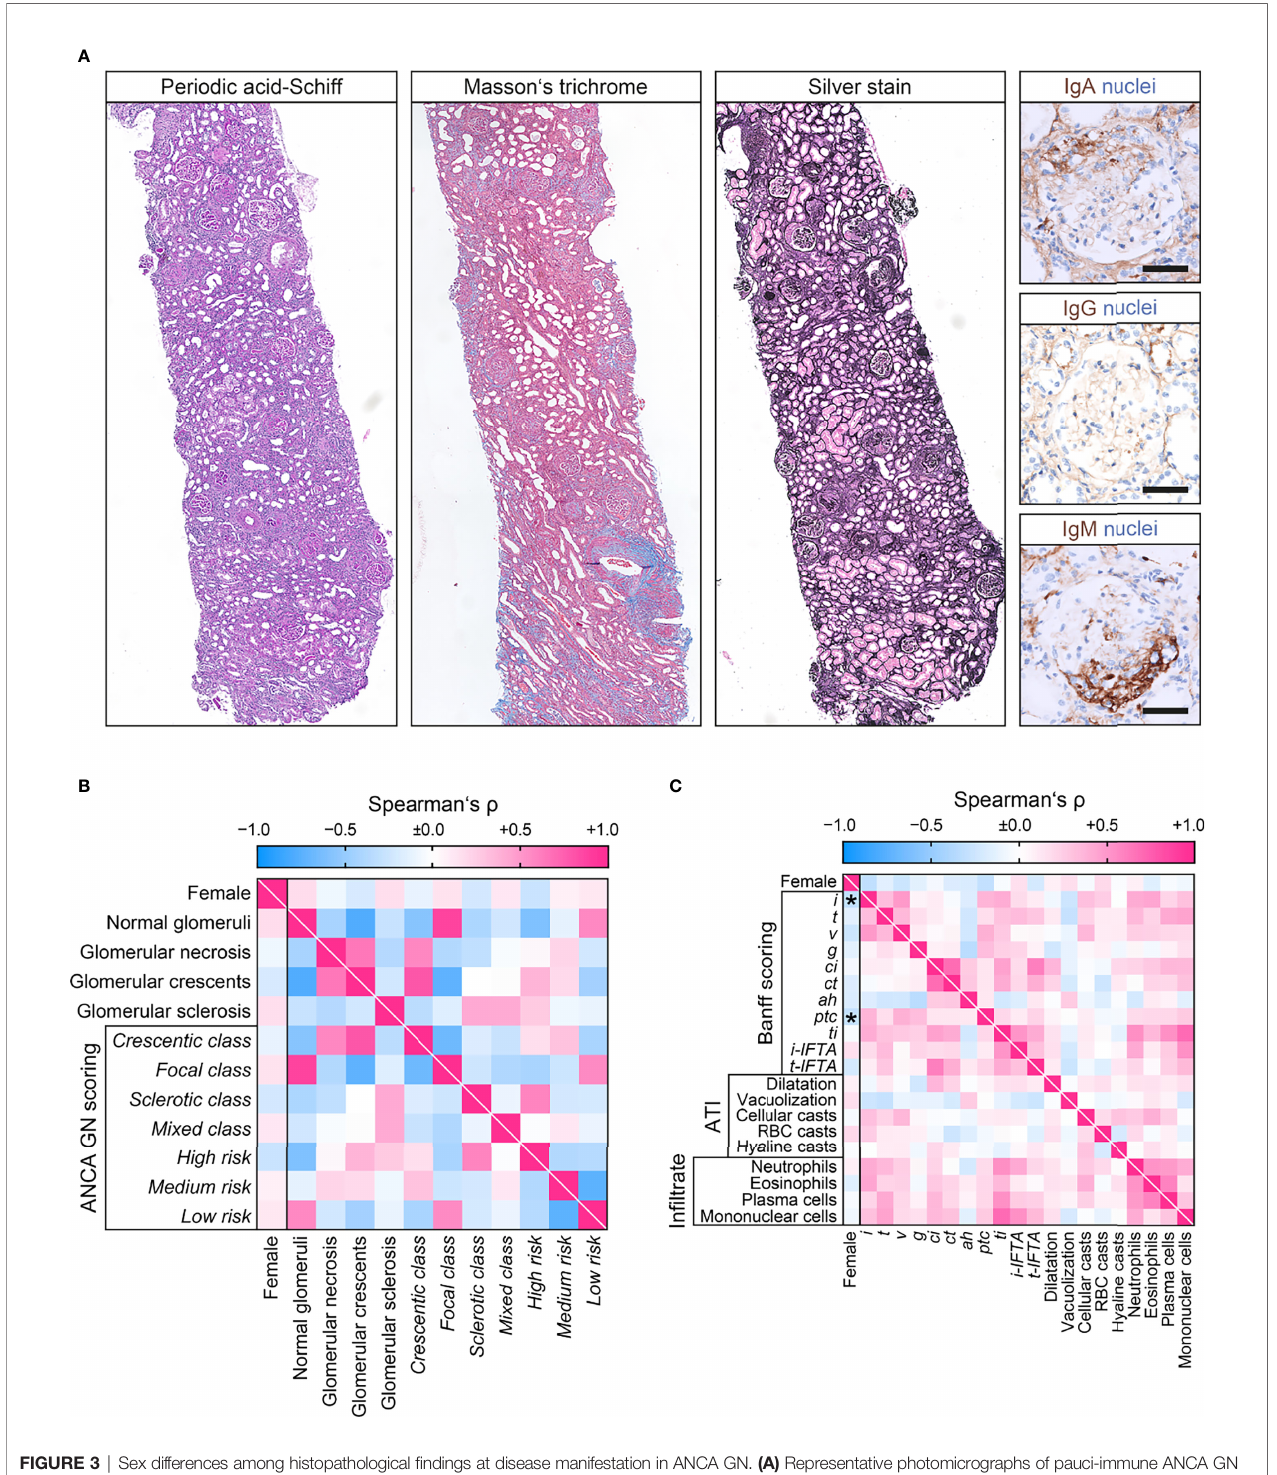
FIGURE 3 | Sex differences among histopathological fi ndings at disease manifestation in ANCA GN. (A) Representative photomicrographs of pauci-immune ANCA GN showing crescent formations with IgM entrapment within cellular proliferations and injured glomerular capilaries. Note, lack of granular or linear staining of IGA and IgA along the GBM typical for pauci-immune GN (scale bars: 50 µm). (B) Sex in association with glomerular lesions and ANCA GN scoring are shown by heatmap re fl ecting mean values of Spearman ’ s r . (C) Sex in association with tubulointerstitial lesions analogous to the Banff scoring system, ATI lesions, and distinct in fl ammatory in fi ltrates are shown by heatmap re fl ecting mean values of Spearman ’ s r , asterisks indicate p<0.05. ah, arteriolar hyalinosis; ANCA, anti-neutrophil cytoplasmic antibodies; ATI, acute tubular injury; ci, interstitial fi brosis; ct, tubular atrophy; g, glomerulitis; GN, glomerulonephritis; i, interstitial in fl ammation; i-IFTA, in fl ammation in IFTA; RBC, red blood cell; t, tubulitis; ptc, peritubular capillaritis; ti, total in fl ammation; t-IFTA, tubulitis in IFTA; v, intimal